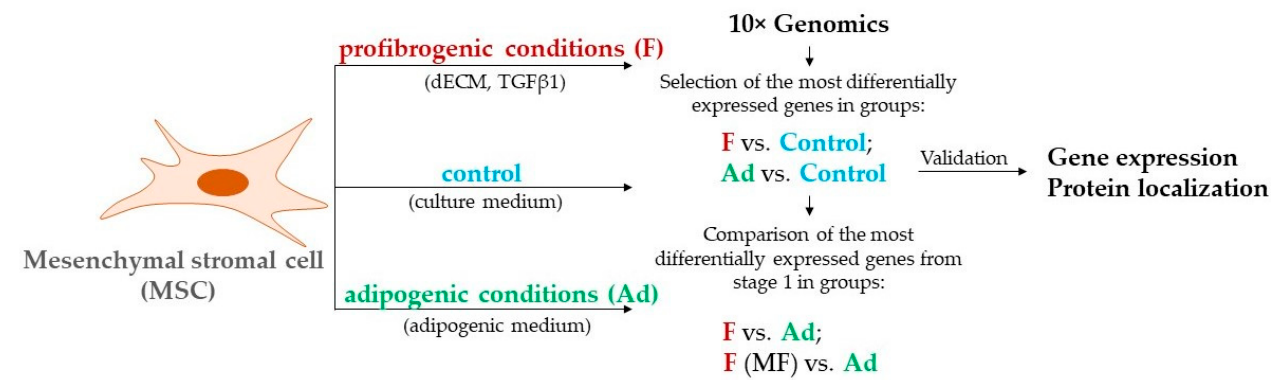
Figure 1. Experimental design included single-cell RNA-Seq (10 × Genomics) of human adipose- derived mesenchymal stromal cells (MSC) in profibrotic conditions (F) or adipogenic conditions (Ad) compared to the control conditions. The genes that changed the expression in these samples were compared between the F and Ad samples of MF (myofibroblast cluster from F sample) and Ad.